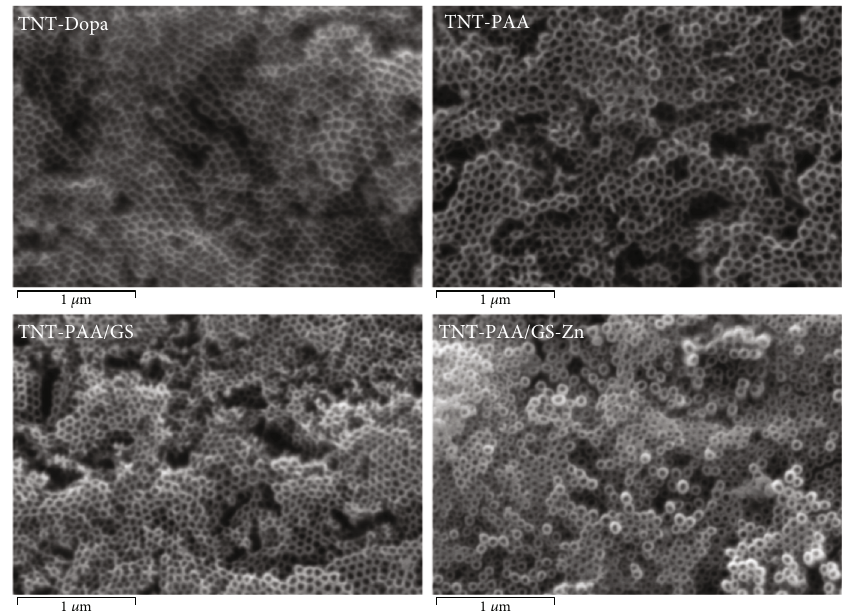
Figure 1: The representative SEM images of surface-modi fi ed titanium oxide nanotubes on the titanium